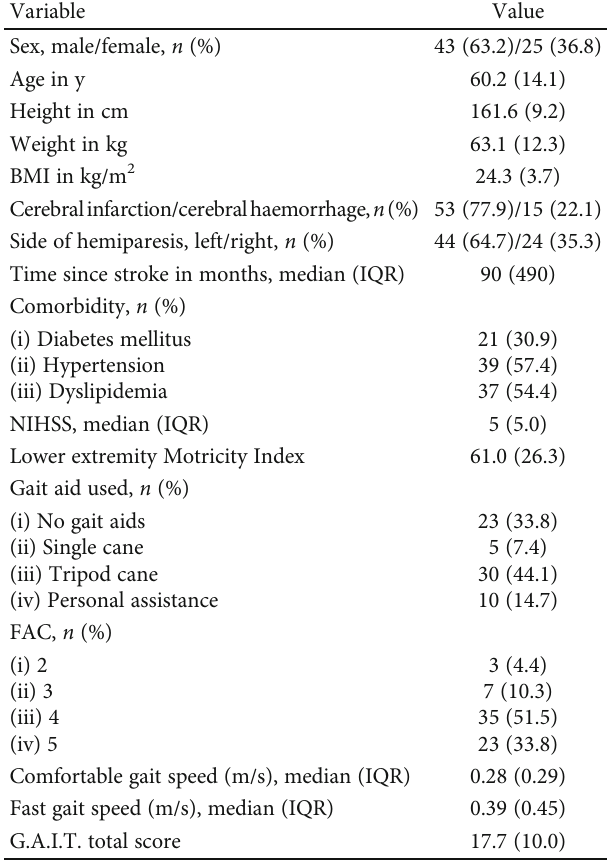
Table 1: Patient demographic data ( n = 68